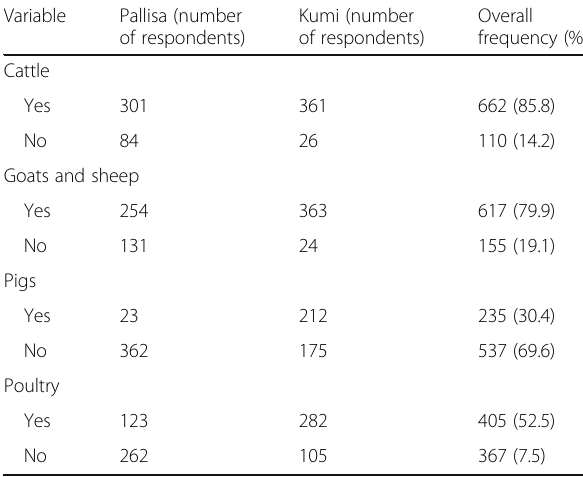
Table 2 Frequencies of types of livestock kept in Pallisa